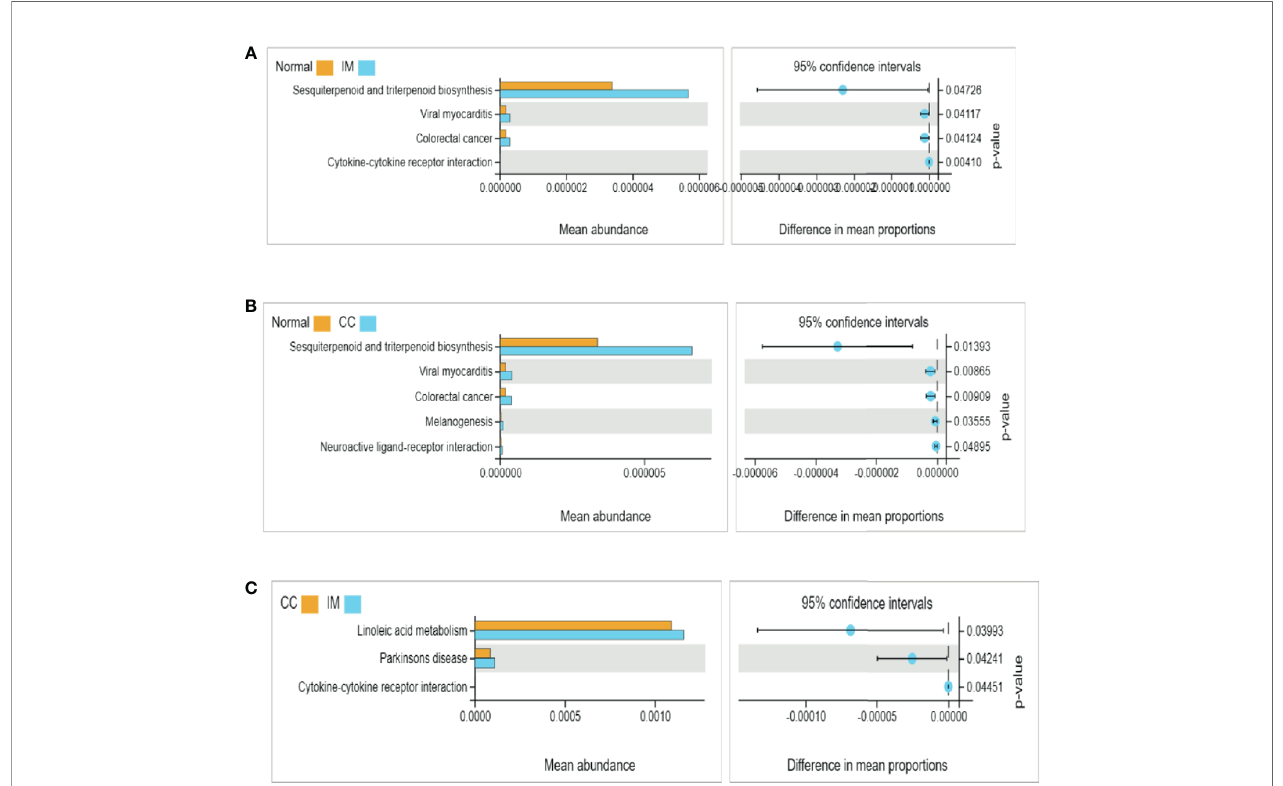
FIGURE 4 | Functional pathway analysis of gut microbiome among IM, CC, and control groups. Microbial functions were predicted using Tax4Fun at the third level of the KEGG pathway, and statistically analyzed by Welch ’ s t-test between groups. KEGG pathways with signi fi cant abundance difference (P < 0.05) are shown. (A) Differential functional pathways between IM subjects and healthy females. (B) Differential functional pathways between CC subjects and healthy females. (C) Differential functional pathways between CC subjects and IM subjects. In each of the fi gures, the left panel shows the abundance of pathway differences between groups, and each bar in the graph represents the mean of each pathway in each group with signi fi cant differences in abundance between the groups. The graph on the right shows the difference between the con fi dence levels of the groups. The leftmost endpoint of each circle in the fi gure represents the 95% con fi dence interval lower limit of the mean difference, and the rightmost endpoint of the circle represents the 95% con fi dence interval upper limit of the mean difference. The center of the circle represents the difference in the mean. The group represented by the circle color is a group with a higher mean. At the far right of the displayed results is the inter-group signi fi cance Welch ’ s t-test p-value for the corresponding